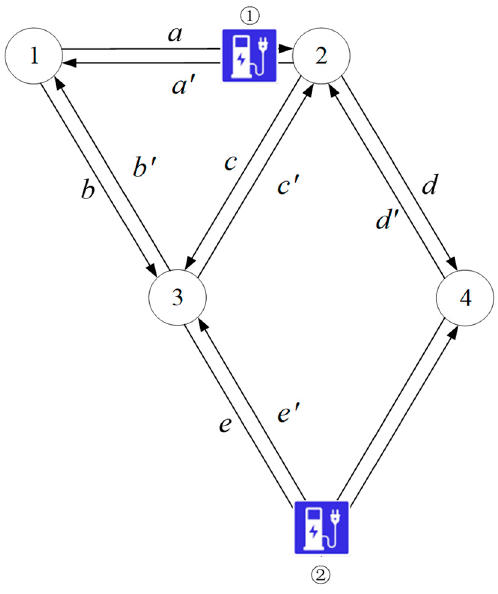
Figure 6. Case of TN. Table 3. Distance of links.